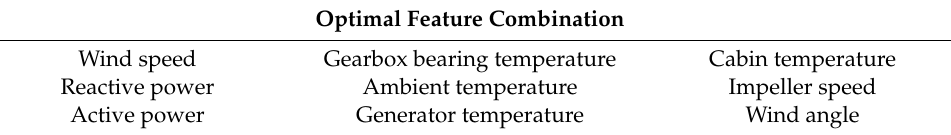
Table 3. Final features combination after random forest (RF) features